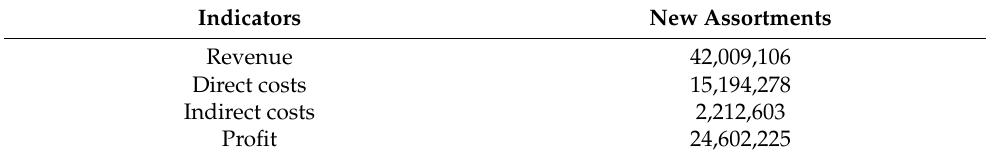
Table 9. Profit calculation of the company with new assortment. Source: own